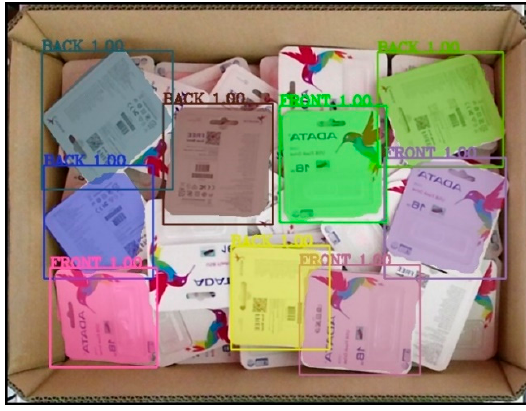
Figure 23. Raw output from the deep learning network.